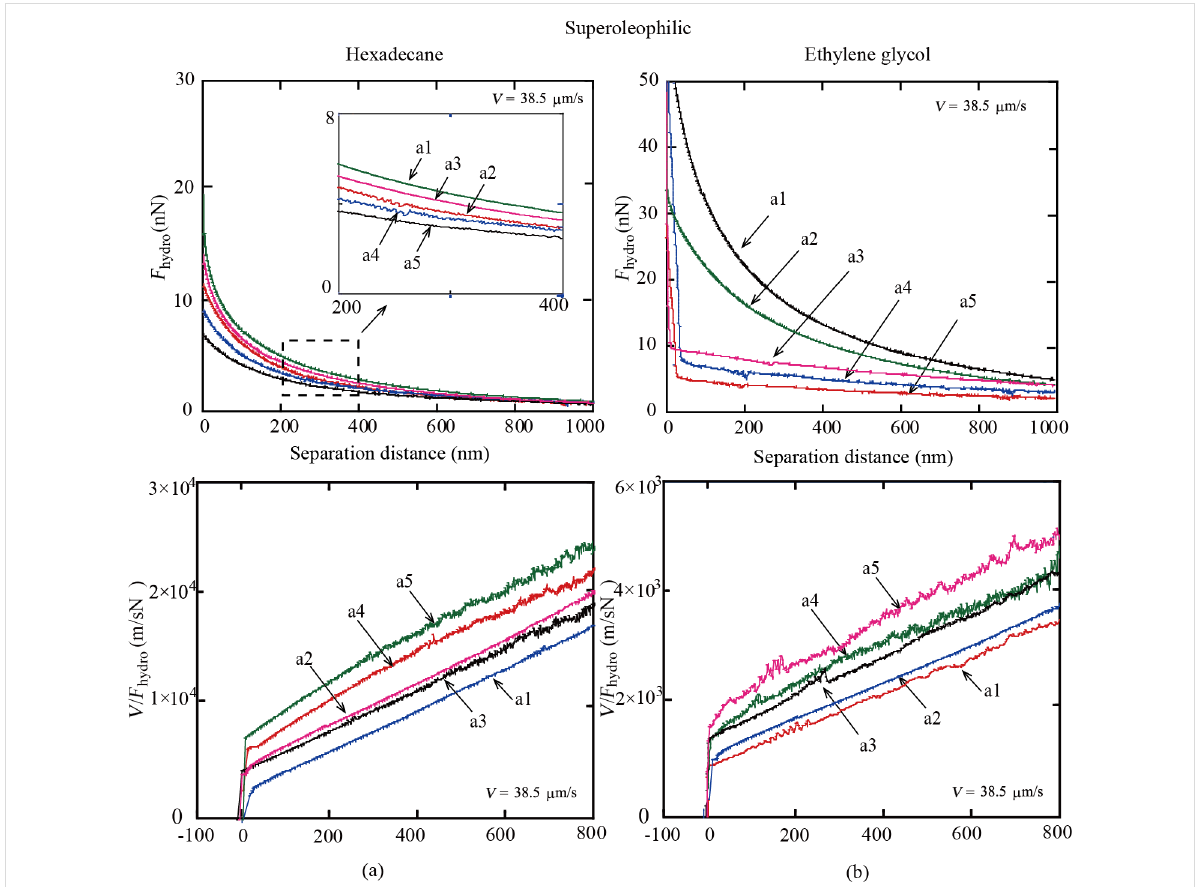
Figure 6: Hydrodynamic force F hydro and V / F hydro of a borosilicate sphere on superoleophilic surfaces a1 to a5 immersed in hexadecane with various values of RMS roughness at a sphere velocity of 38.5 μ m/s.